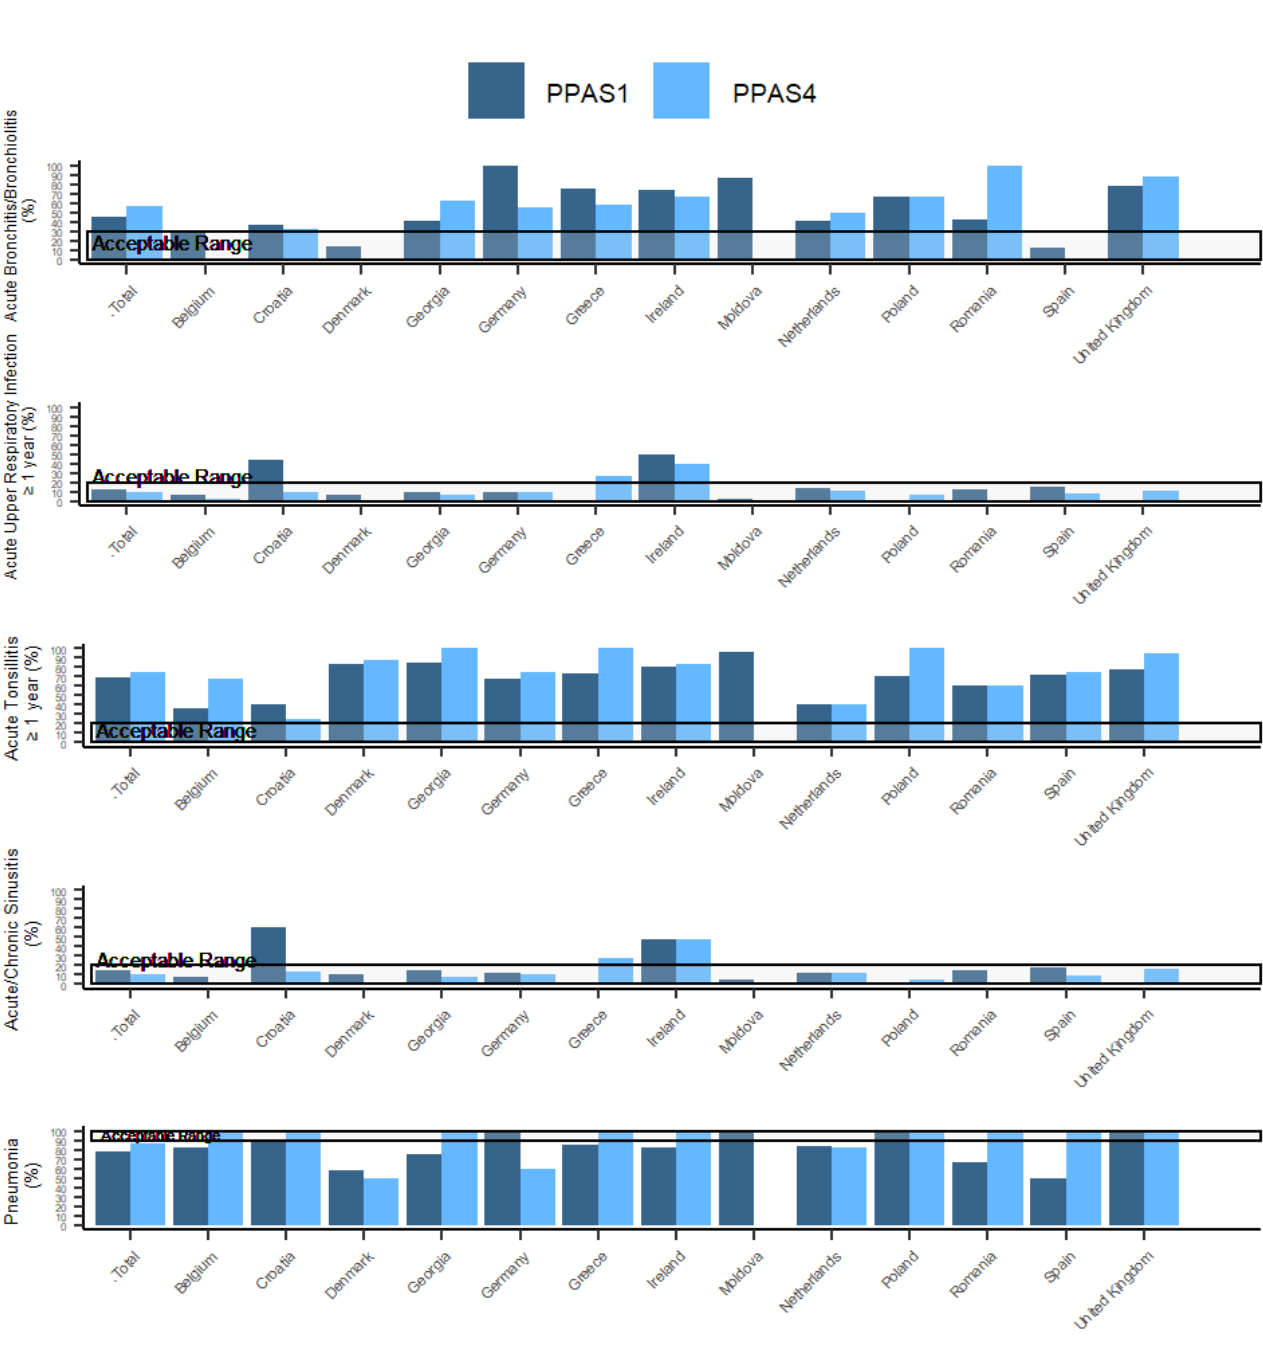
Figure 3. ESAC quality indicators (acceptable range) for PPAS-1 and PPAS-4. Percentage antibiotic prescribing overall and by country, for each condition for adults, unless otherwise stated.